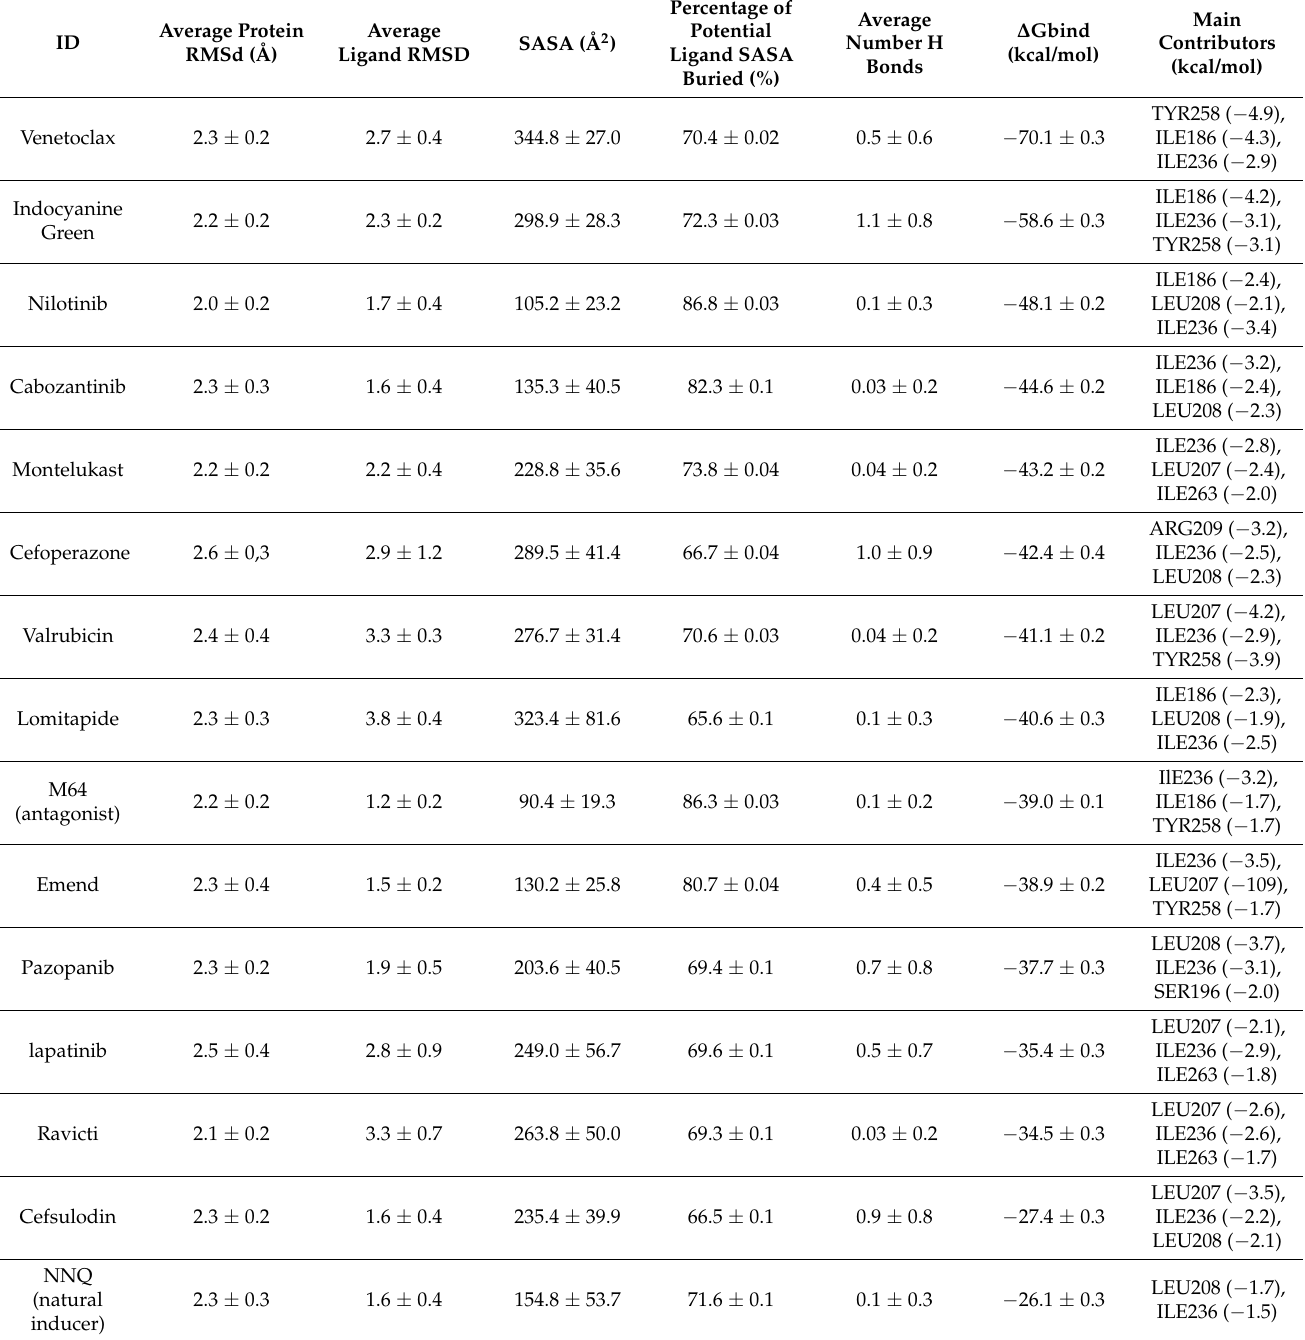
Table 4. Average protein RMSD values (Å), average ligand RMSD (Å), average MvfR–ligand complex SASA (Å 2 ), percentage of SASA for the buried ligand, and average number of ligand hydrogen bonds, obtained from the MD simulations of MvfR–FDA complexes. ∆ G binding energy determined using MM/GBSA and per-residue decomposition, calculated for the last 90 ns of the simulation. Compounds are ordered by increasing ∆ Gbind